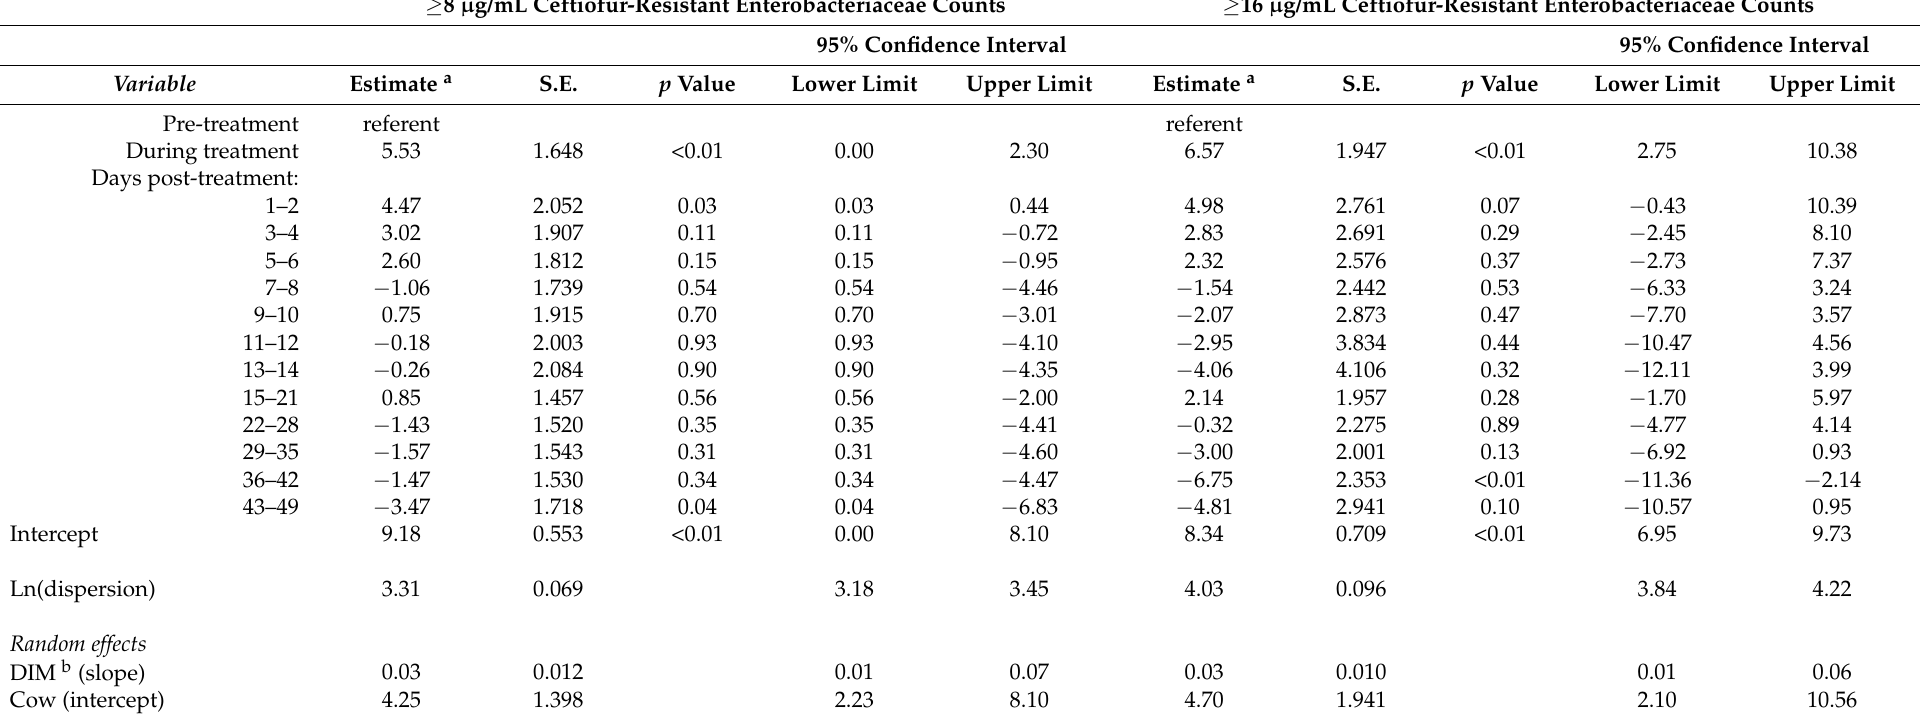
Table 4. Multilevel mixed effect negative binomial estimates for ≥ 8 µ g/mL and ≥ 16 µ g/mL ceftiofur-resistant Enterobacteriaceae counts post-systemic antimicrobial drug treatments in 45 cows on one California dairy (Farm B) over two